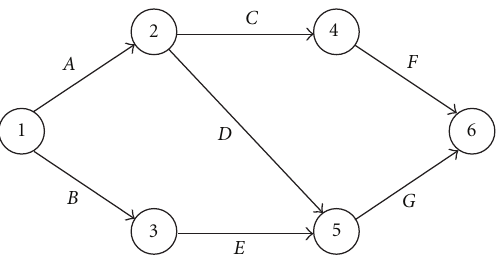
Figure 4: The classical